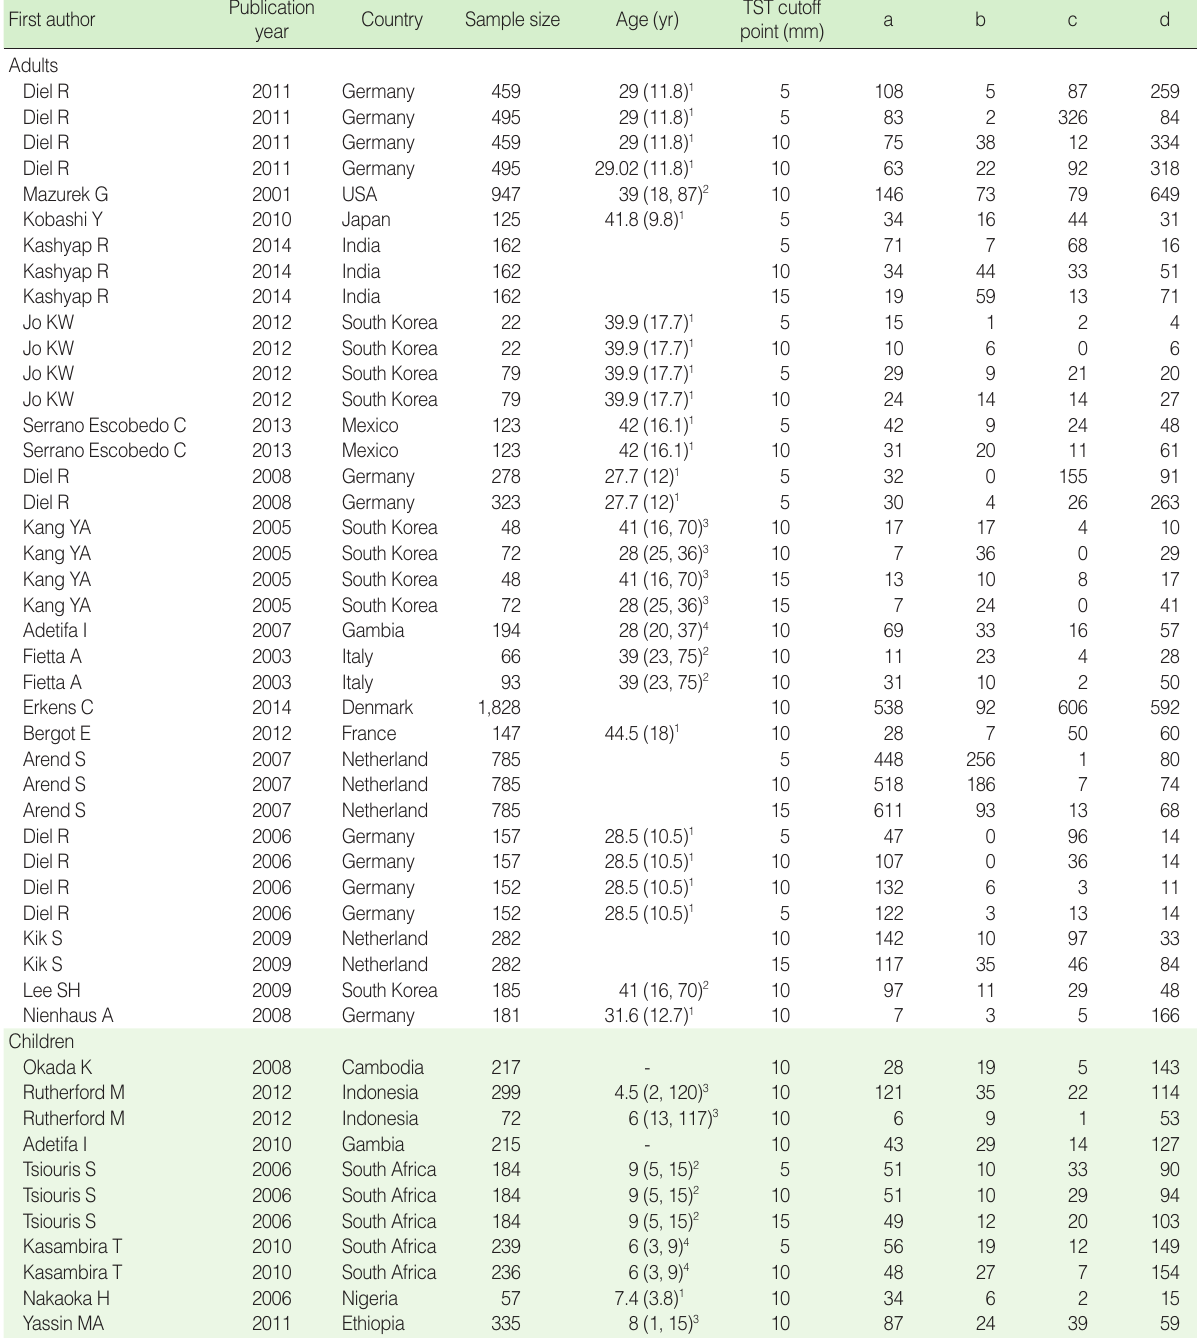
Table 1. Characteristics of the studies included in the